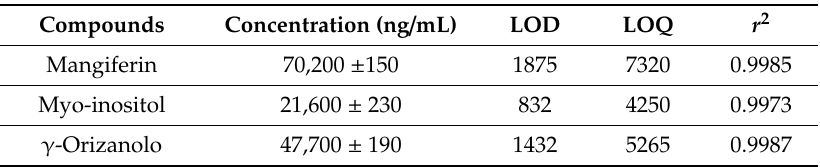
Table 1. Methodology of evaluations and biological samples preparations are reported in a